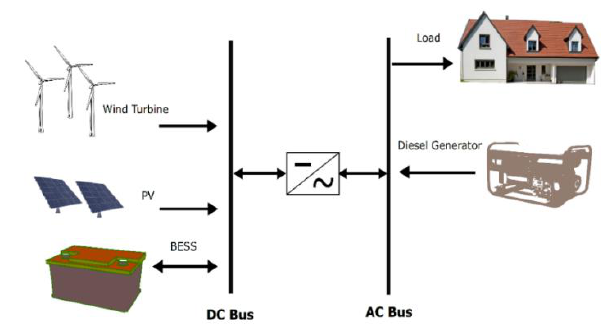
Figure 3. Microgrid Hybrid system